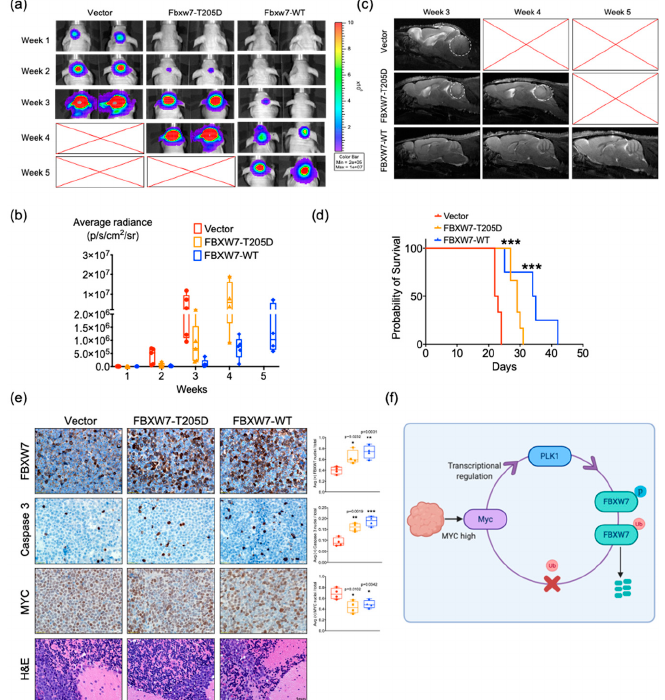
Figure 6. Activation of FBXW7 is a potential therapeutic strategy for MYC-driven medulloblas- toma. ( a , b ) Representative images of bioluminescence imaging from nude mice xenografts injected with D458 cells expressing FBXW7 (wild-type or T205D mutant) or a vector. n = 7 for each group. ( c ) Representative sagittal T2-weighted turboRARE (rapid acquisition with relaxation enhancement) MR images on cerebellar D458 tumor lesions expressing FBXW7 (wild-type and T205D mutant) or a vector. ( d ) Kaplan–Meier survival plot from intracranial orthotopic mouse model. *** p < 0.001, Log-rank (Mantel–Cox) test. ( e ) Immunohistochemical staining of MB from intracranial orthotopic mouse model for FBXW7, c-MYC, Caspase 3, and H&E. Images taken at 40 × . Mean ± SD; * p < 0.05; ** p < 0.01; *** p < 0.001 (one-way ANOVA). ( f ) Proposed model depicting the PLK1-MYC-FBXW7 signaling cir- cuits. PLK1 promotes FBXW7 auto poly-ubiquitination and proteasomal degradation, counteracting the FBXW7-mediated degradation of c-MYC. In turn, stabilized c-MYC directly activates PLK1 transcription, constituting regulatory